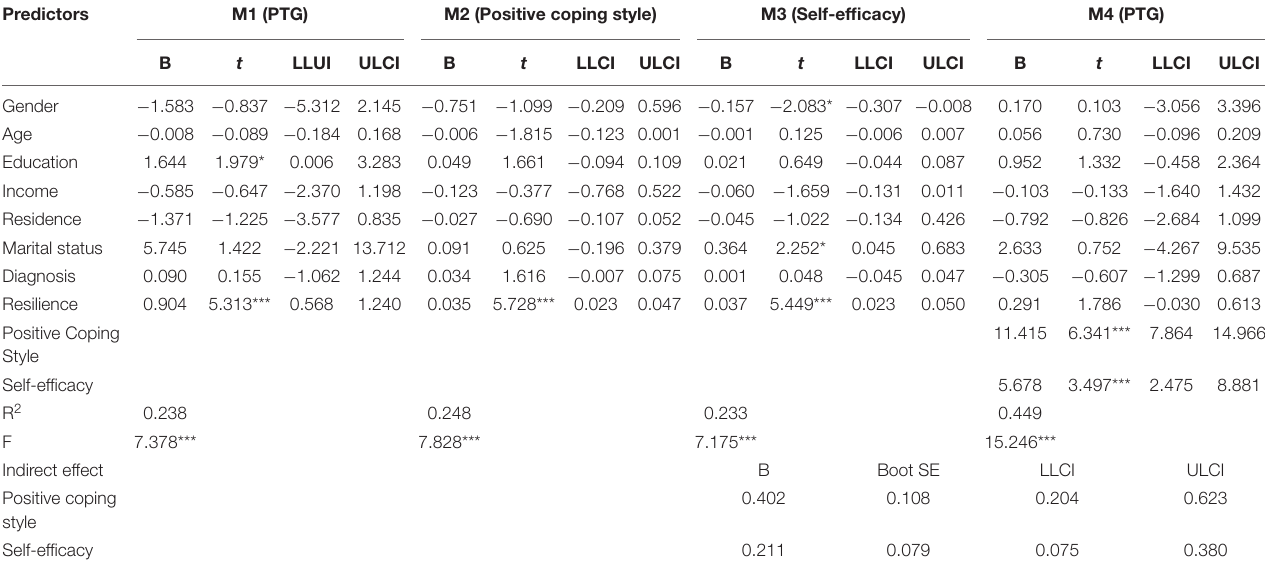
TABLE 3 | Mediation effect